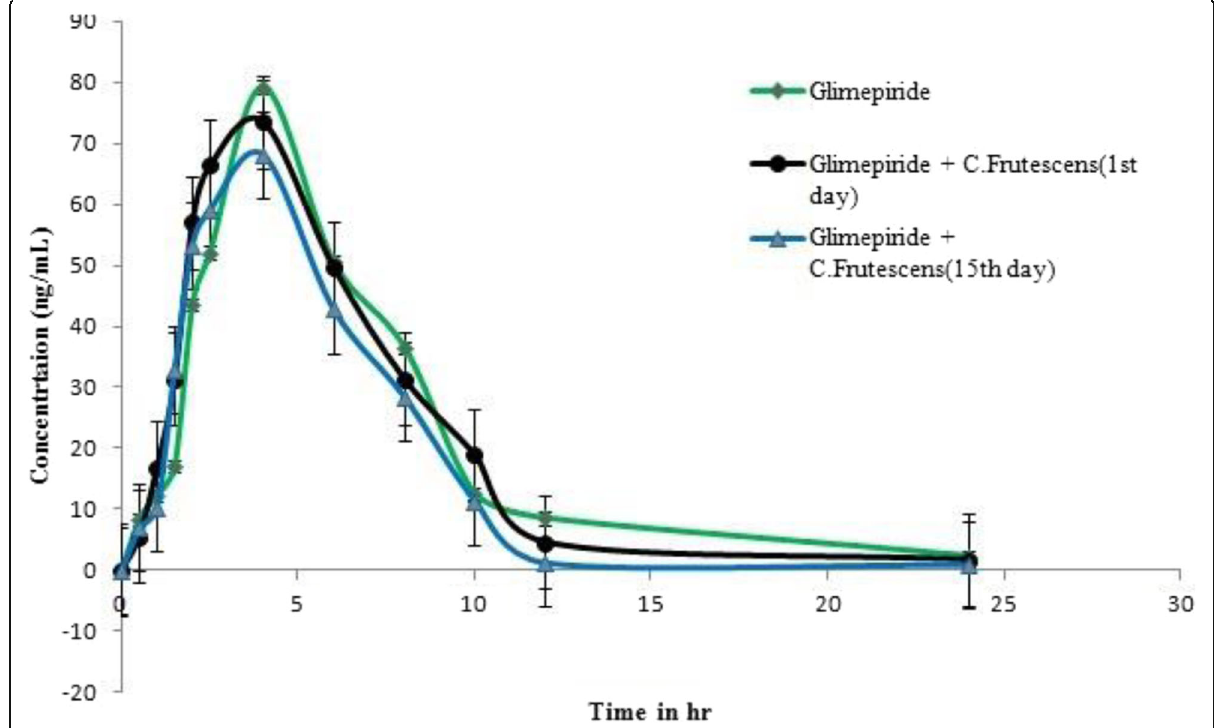
Fig. 5 Plasma concentration vs time profile of glimepiride, glimepiride+ C. frutescens (1st day) and glimepiride+ C. frutescens (15th